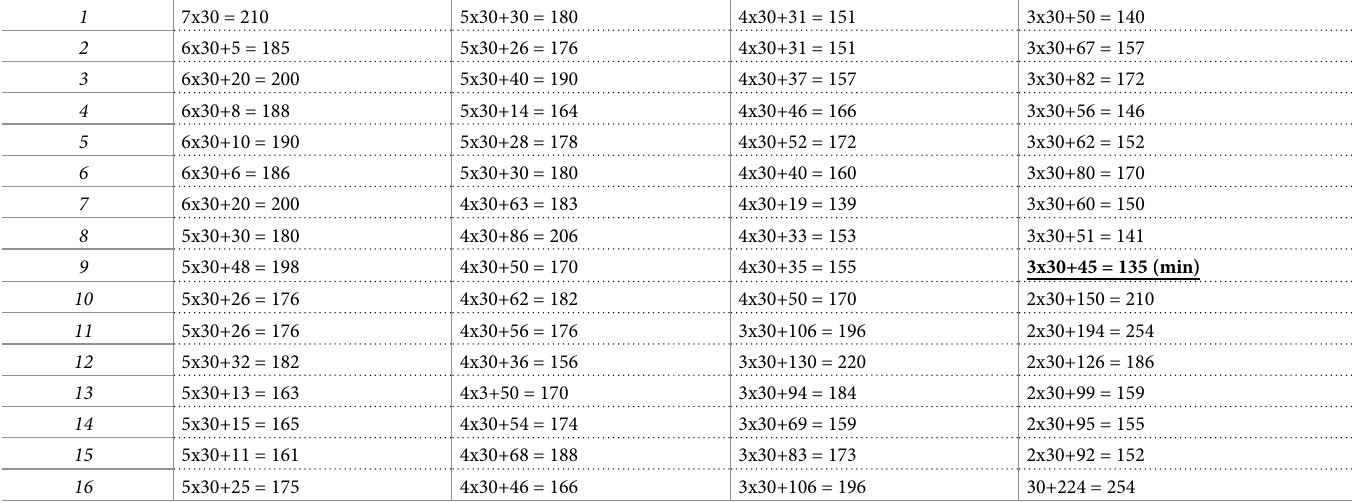
Table 4. Combinatorial cost